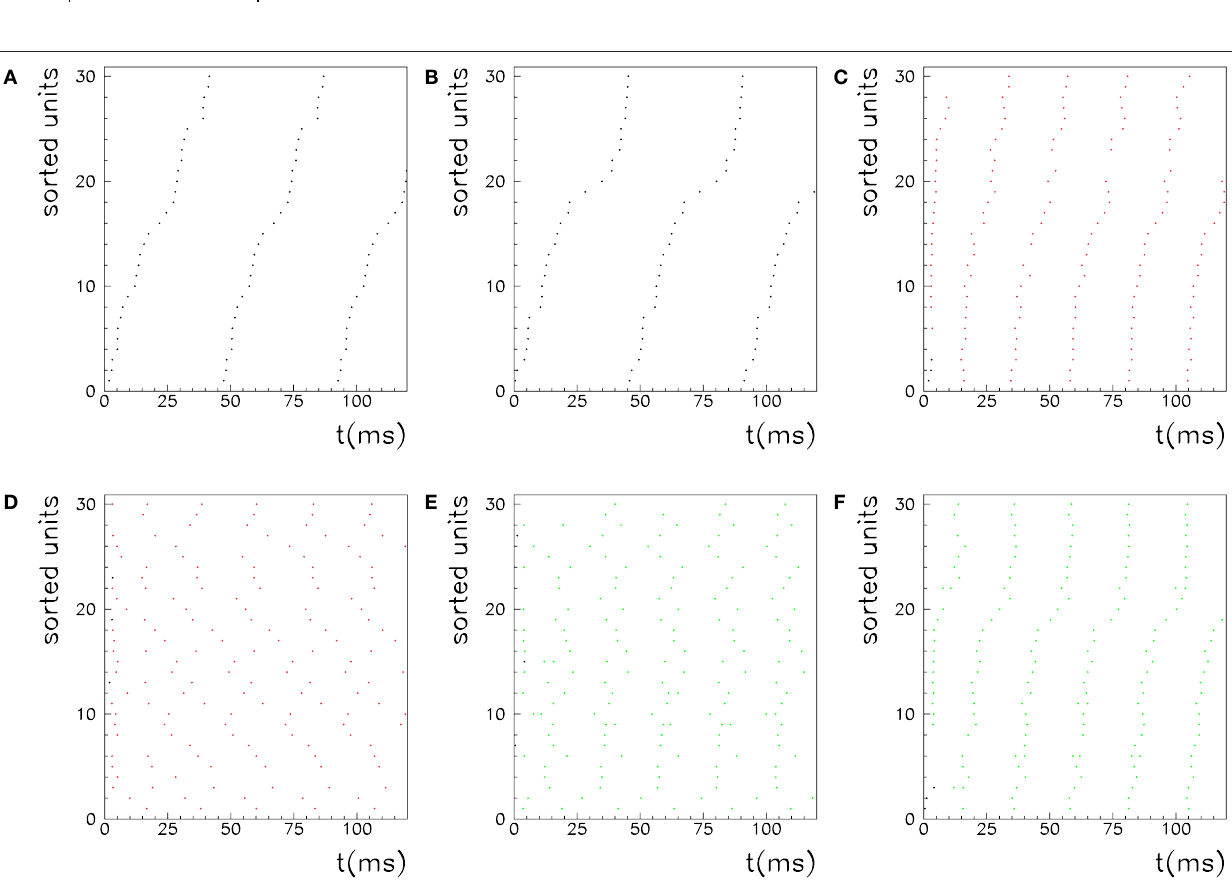
generated dynamics when a short train of M = 100 spikes corresponding to the Figure 6 | example of selective retrieval of different patterns, in a network μ = 1 pattern is induced on the network, while in (C) and (F) the dynamics when with N = 1000 iF neurons and P = 5 stored patterns. Here we choose the the μ = 2 pattern is instead triggered. The network dynamics selectively replay asymmetry parameter to be ϕ * = − 0.4 π . Thirty neurons are chosen randomly, 2 in (D–F) . 1 in (A–C) , and sorted by the value of φ the stored pattern, depending on the partial cue stimulation. Note that, because and then sorted by the value of ϕ i i the parameter ϕ * here is greater than in Figure 5 , the frequency of the retrieved In (A) and (D) we show the phases of the first two stored patterns, plotting the pattern here is times ( )/ φ n + 2 respectively for μ = 1 and μ = 2. In (B) and (e) we show the